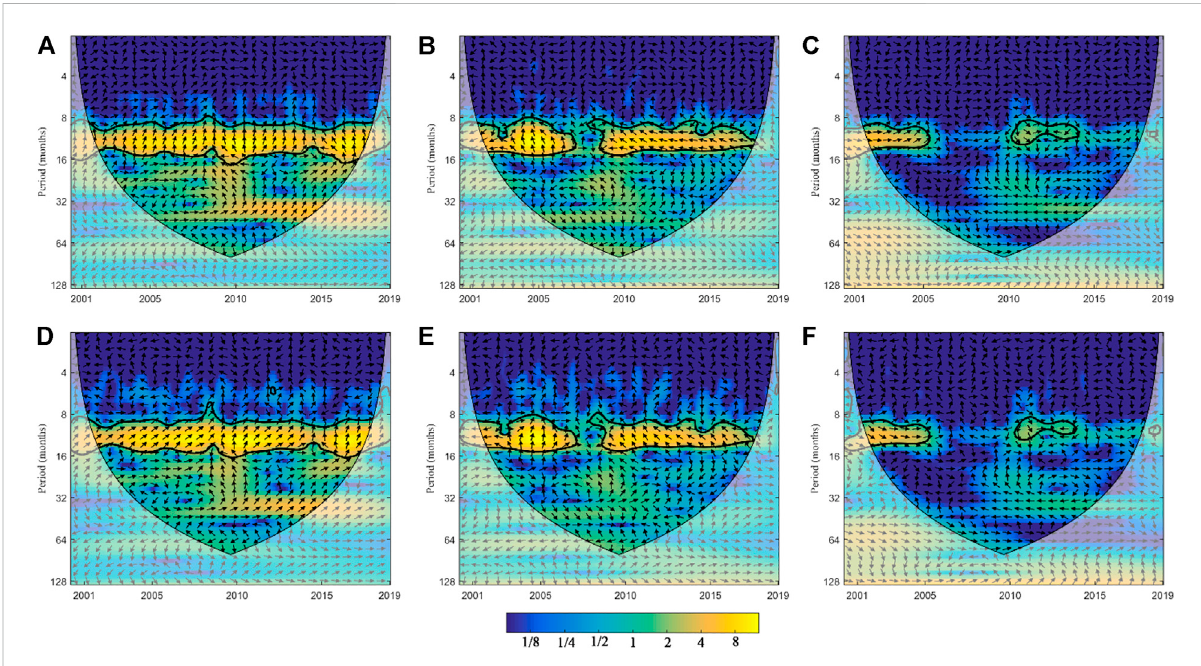
FIGURE 10 The XWT between the monthly SPI5 (A – C) /SPI3 series (D – F) and large-scale climate patterns and solar activity in the